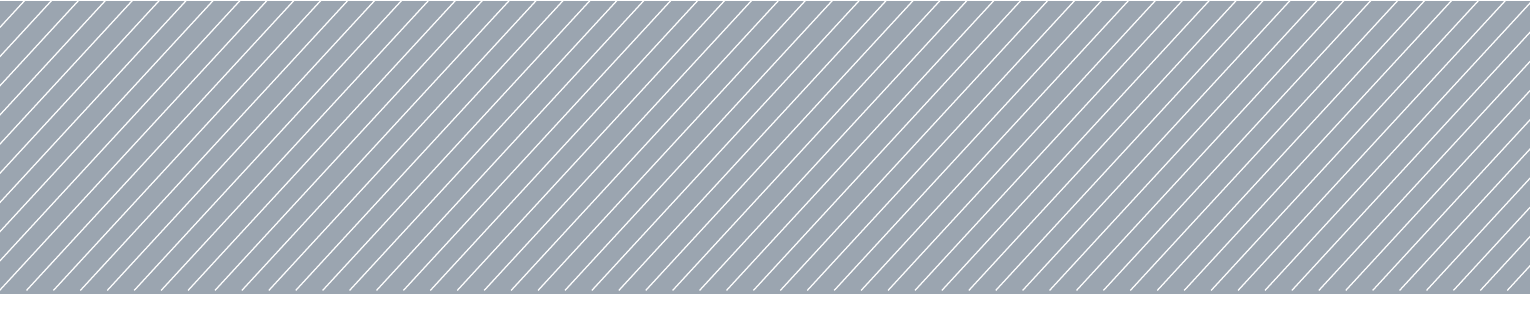
TOP HISPANIC-TARGETED BRANDS* These brands all spent more than $5 million in Spanish-language advertising in 2017 and ranked in the top-10 for Spanish-language advertising spending, proportion of TV budgets allocated to Spanish-language TV, and/or Hispanic youth exposure to Spanish- language